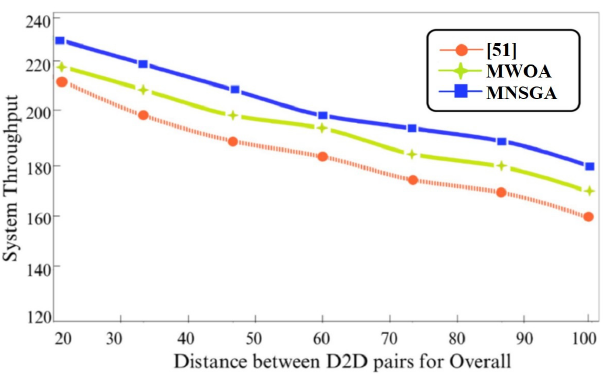
Figure 11. Overall throughputs for various distances between D2D pairs [51].